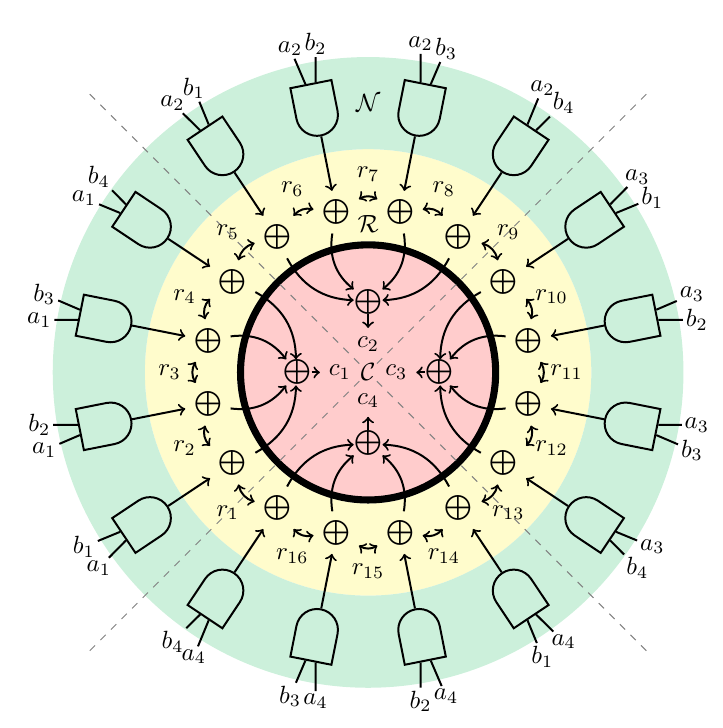
Figure 1: Architecture of CMS multiplication extending the proposal in [CRB + 16] to d = 3, consisting of the (green) non-linear layer N , the (yellow) (ring) refresh layer R , the (black) synchronization (registers) layer S , and the (red) compression layer C